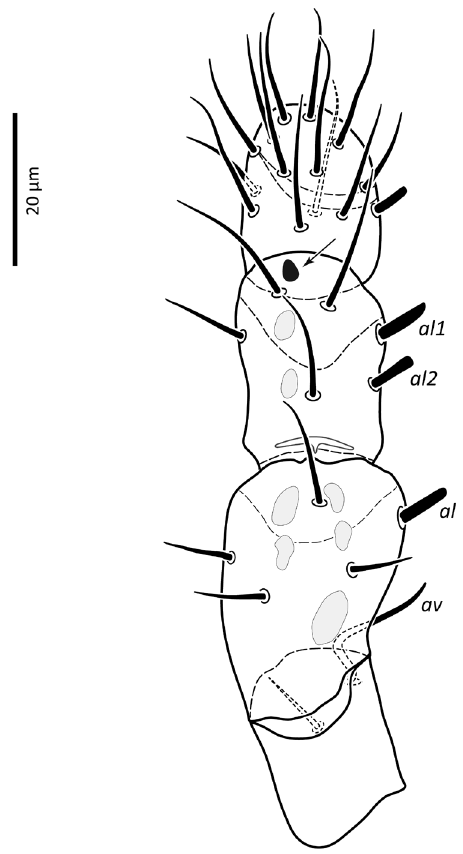
Figure 9. Zygoseius papaver sp. n., female, palp, excluding tarsus, dorsal view.